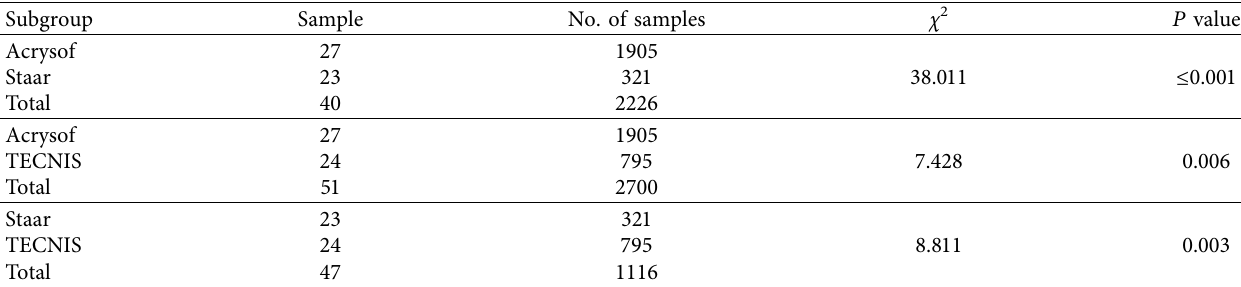
Figure 5: The forest plots displaying the pooled incidence rate of repositioning surgery of (a) Acrysof toric IOLs, (b) Staar IOLs, and (c) TECNIS toric IOLs. Table 3: Pairwise comparison of multiple sample rates by the partitions of the χ 2